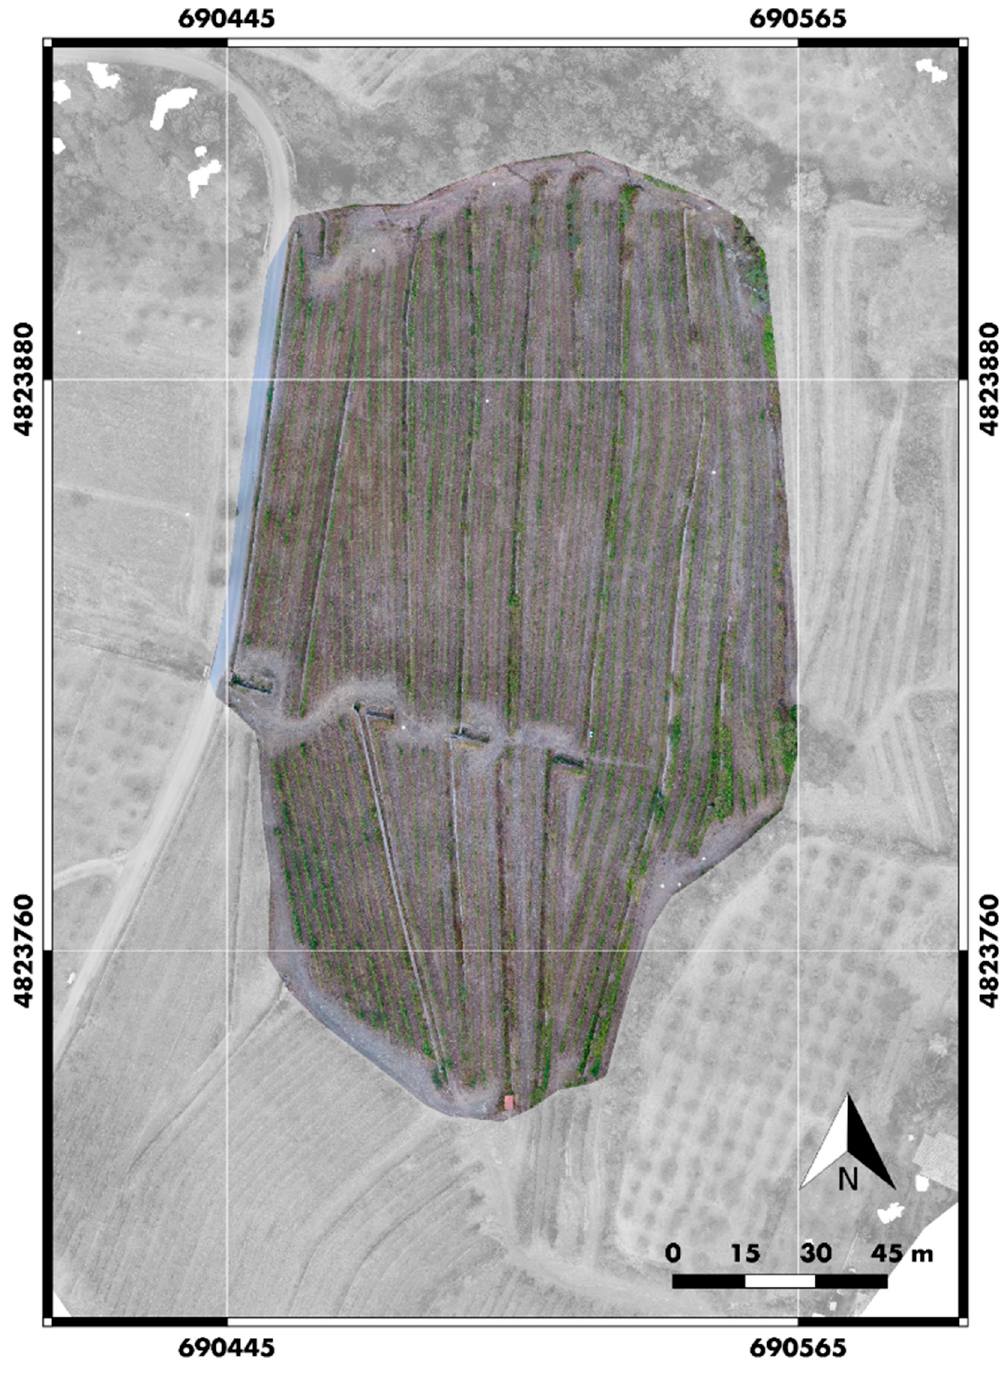
Figure 4. The orthophoto of the study area produced by the photogrammetric processing of the images acquired from the RGB flight over the Grospoli